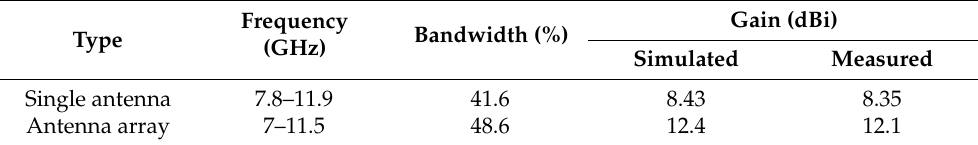
Figure 19. The efficiency of the proposed antenna array was better than 80.0% that of the TSA + DL. Table 3. Comparison of the performance of the antenna element and